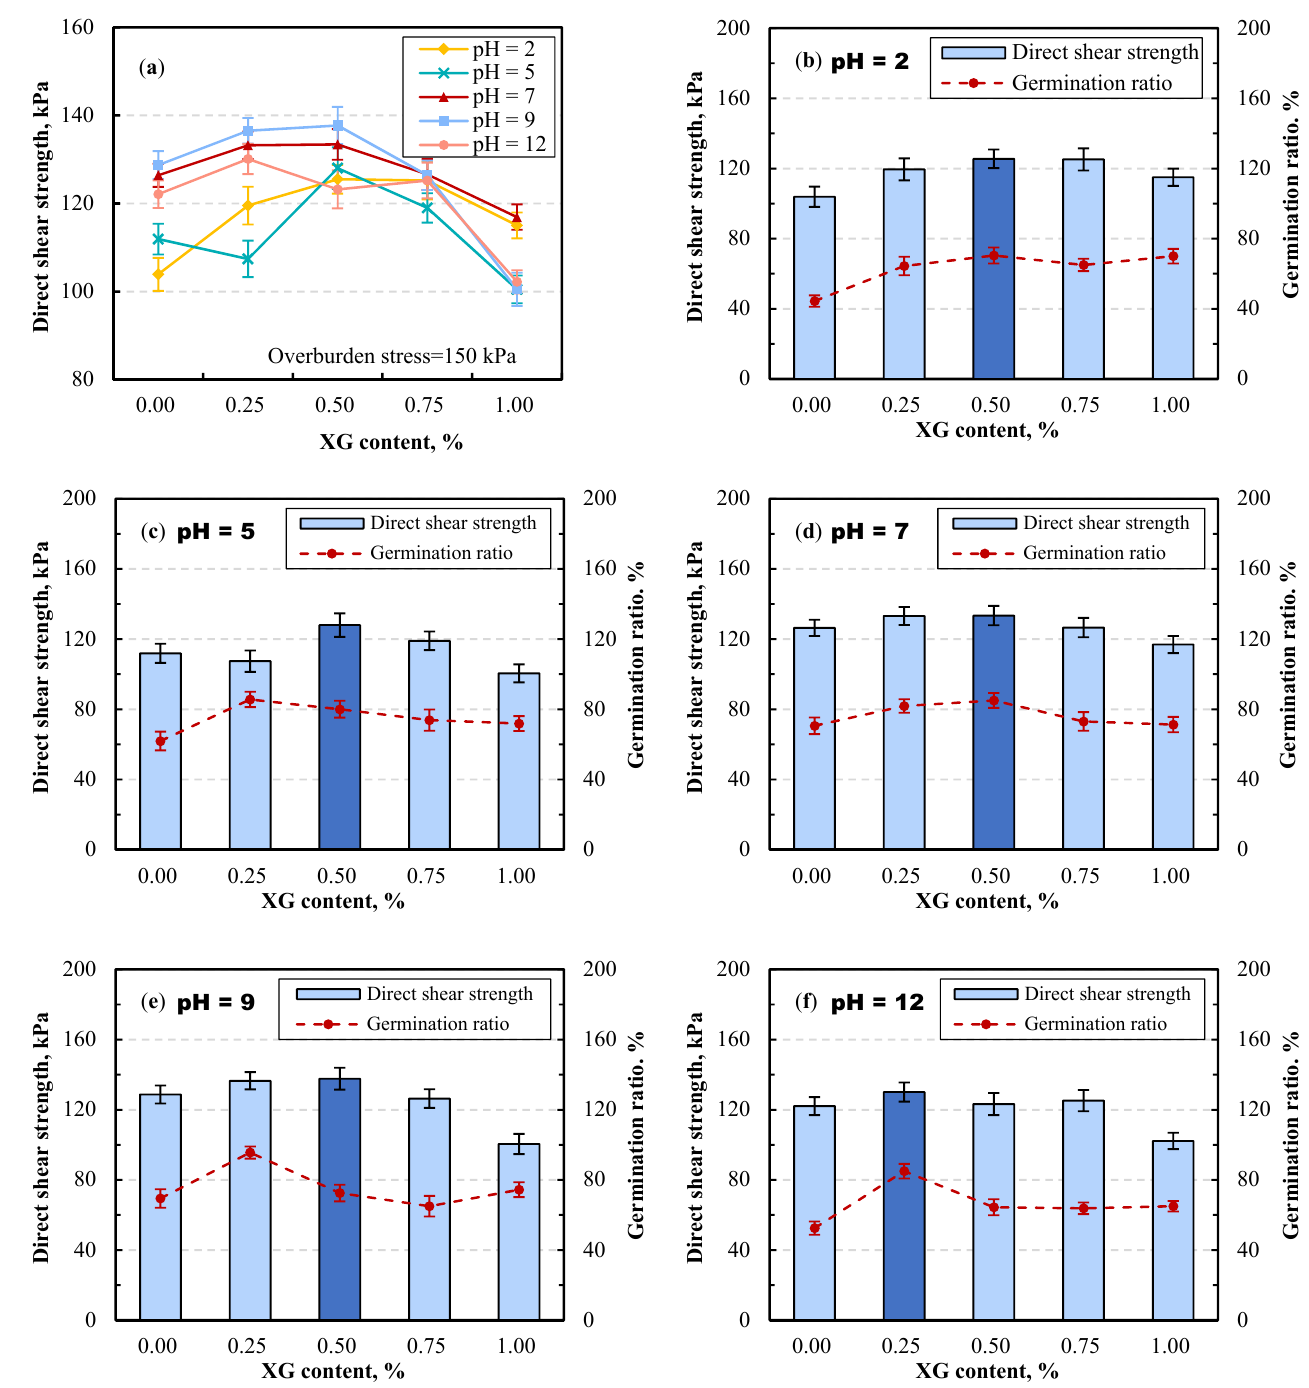
Figure 16. ( a ) Direct shear strength versus XG content; ( b ) direct shear strength and germination ratio versus XG content (pH = 2); ( c ) direct shear strength and germination ratio versus XG content (pH = 5); ( d ) direct shear strength and germination ratio versus XG content (pH = 7); ( e ) direct shear strength and germination ratio versus XG content (pH = 9); ( f ) direct shear strength and germination ratio versus XG content (pH = 12) for the soils under overburden stress = 150 kPa.